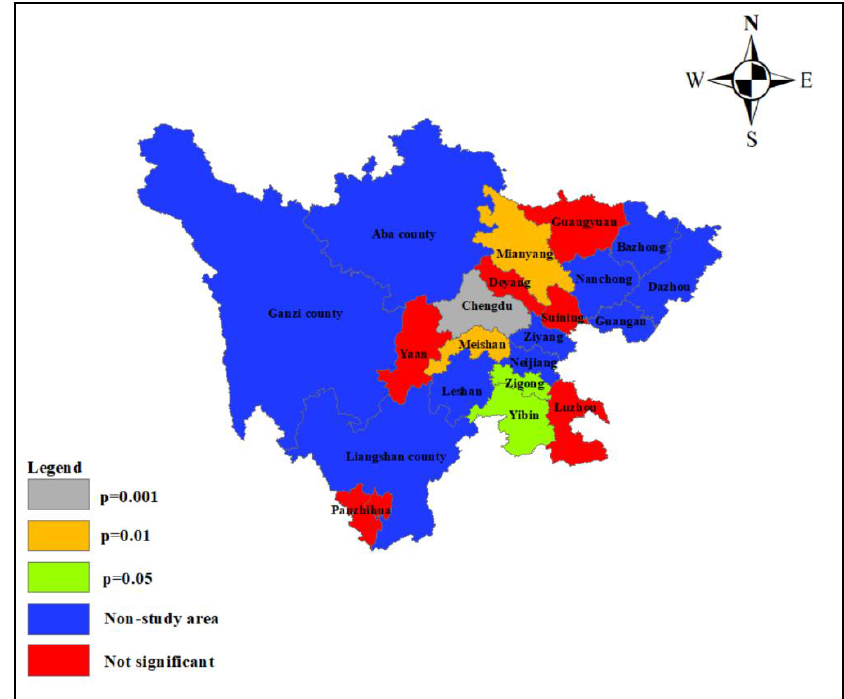
Figure 16. Reliability of local Moran’s I statistic calculation results in 2015.